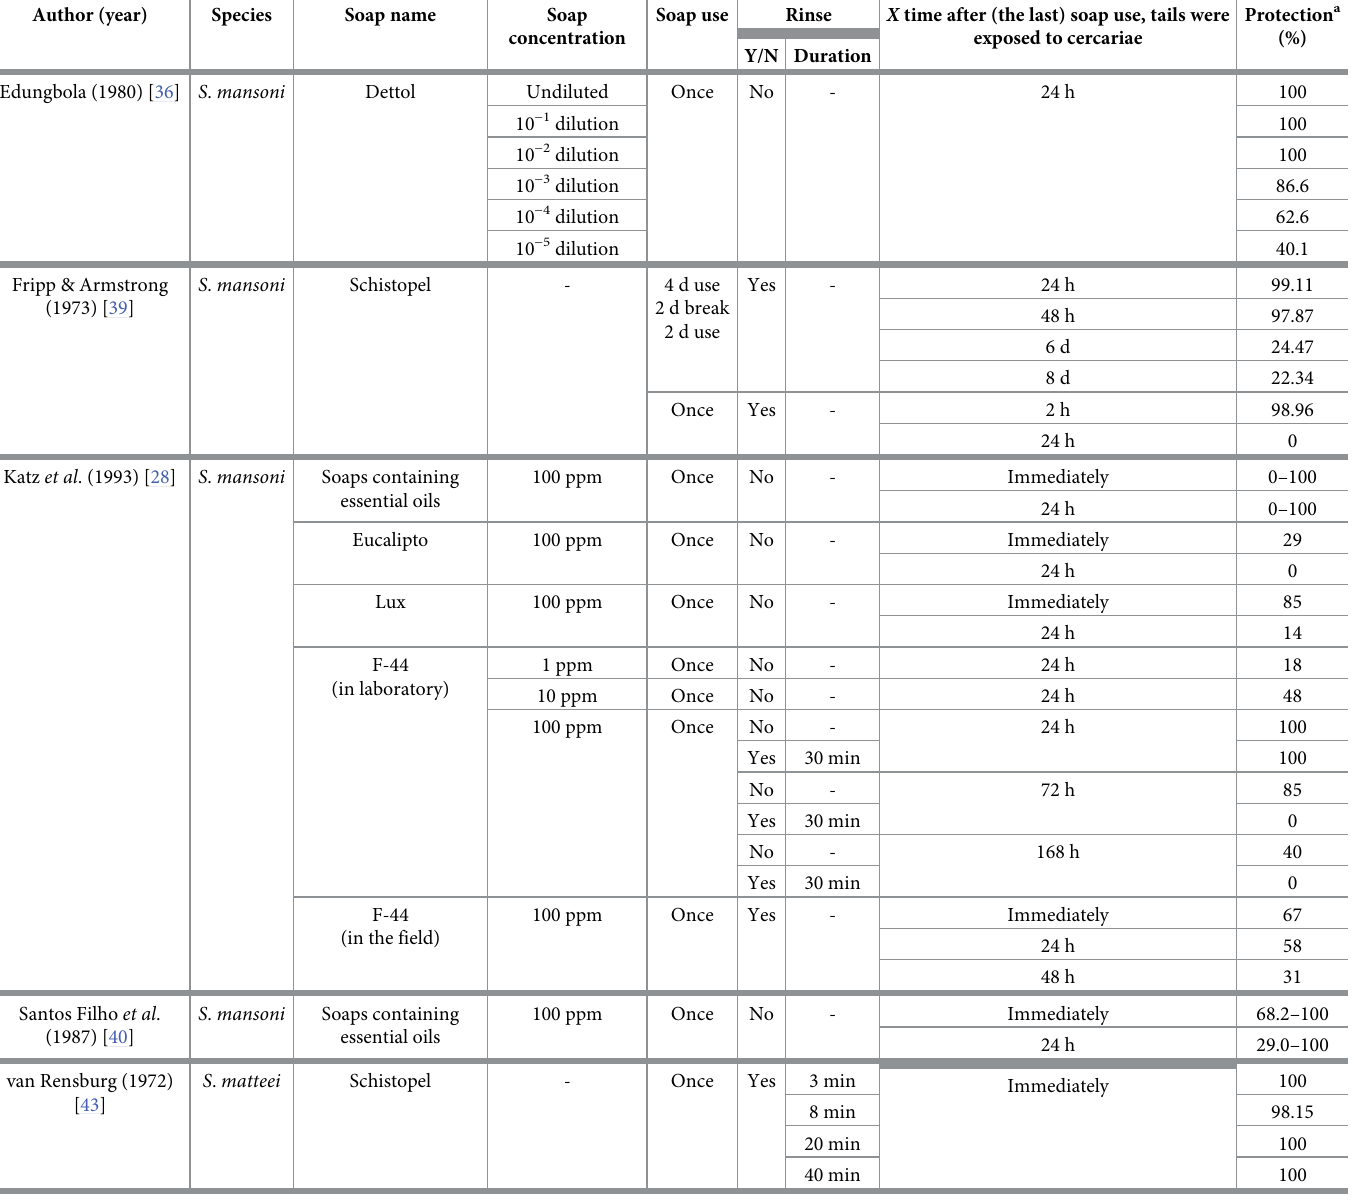
Table 2. The protective effect of soap on rodent tails under different